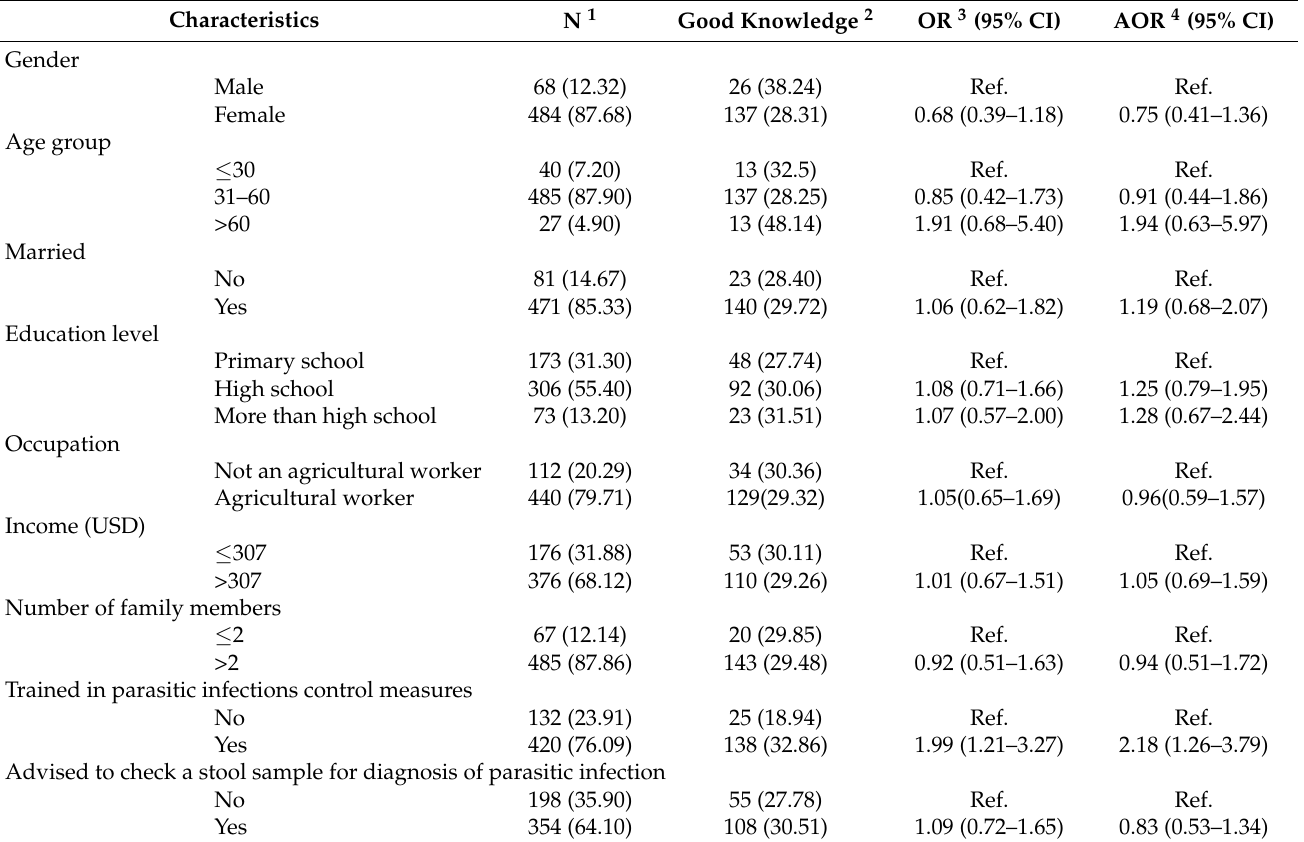
Table 4. Univariate and multivariate mixed-effect logistic regression analysis of factors influencing